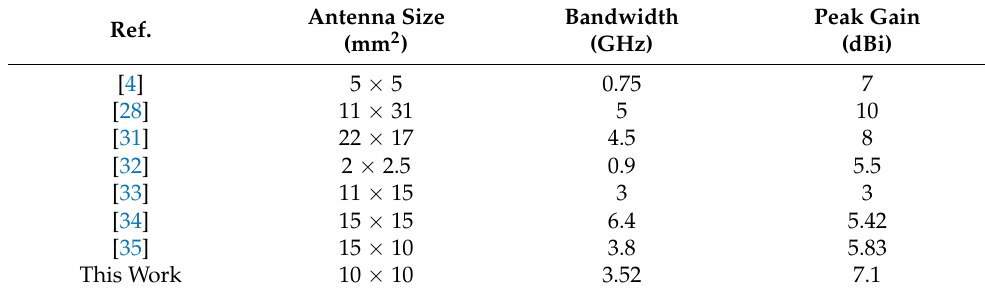
Table 1. Comparison of Proposed work with already published work.